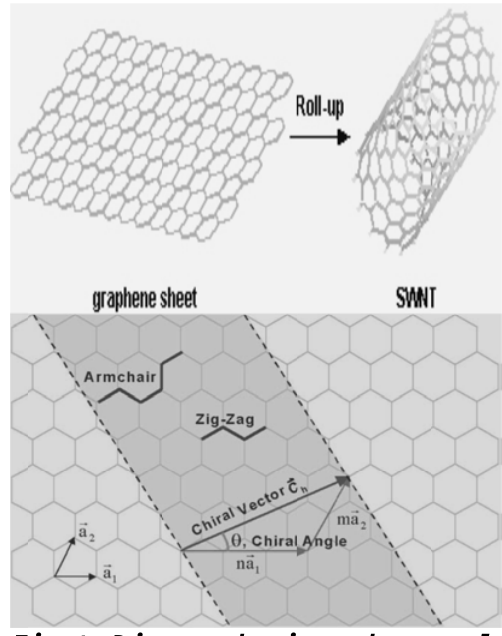
Fig. 1: Diag heet of